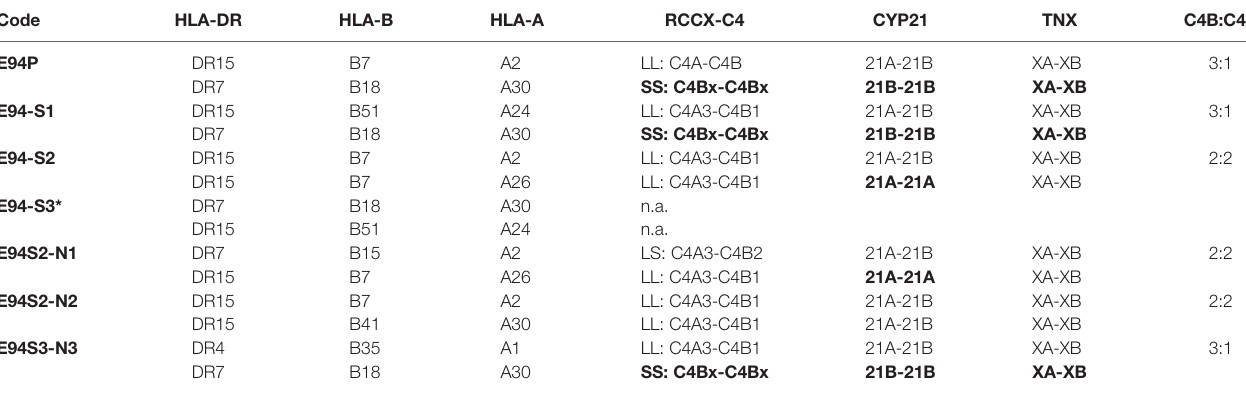
TABLE 3 | A summary of HLA and RCCX haplotypes in the E94 family with multiplex SLE-mortality.